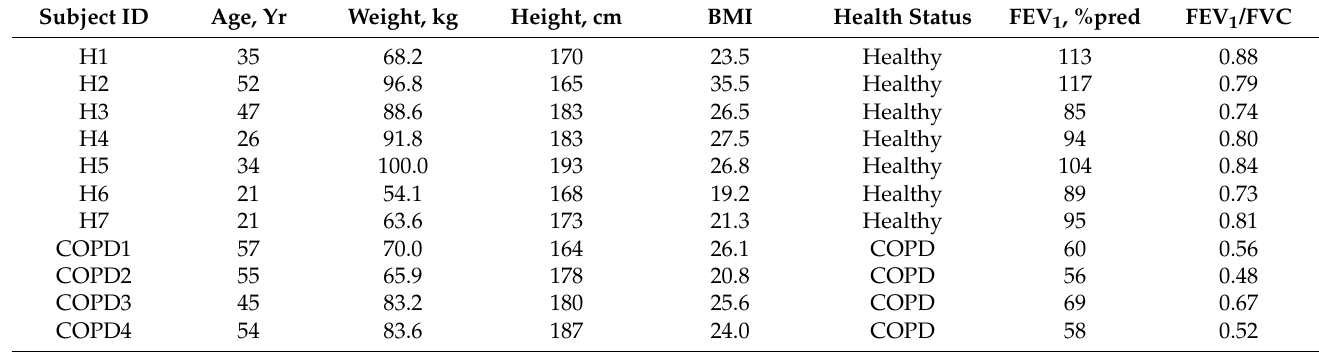
Table 1. Anthropometric